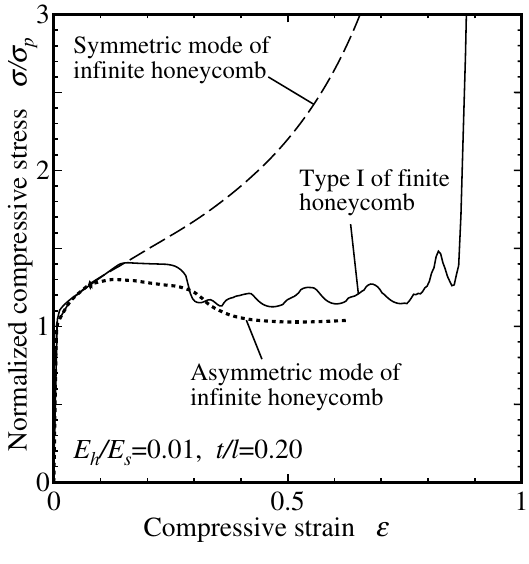
Figure 18. Stress-strain responses for finite and infinite honeycombs (Type I; t/l = 0.20).